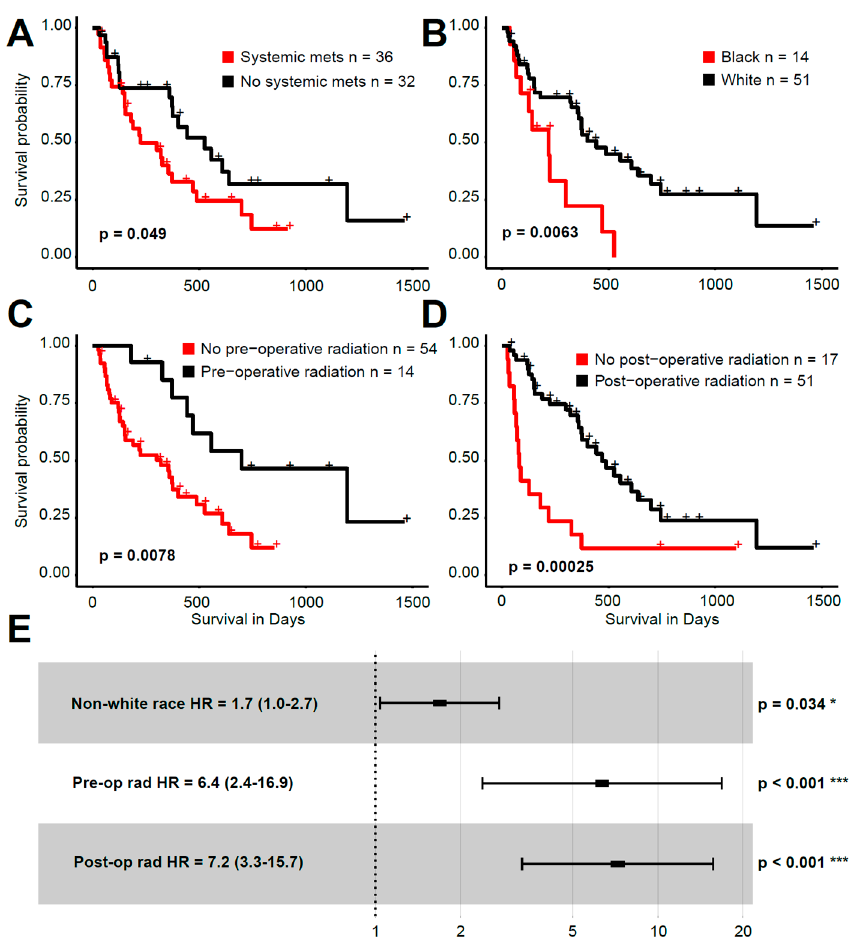
Figure 5. ( A – D ) Kaplan–Meier plots of overall survival for clinical features with univariate signifi- cance. ( E ): Forest plot of the hazard ratios (HR) for a multivariate Cox proportional hazards survival model (HR followed by 95% confidence interval in parentheses).